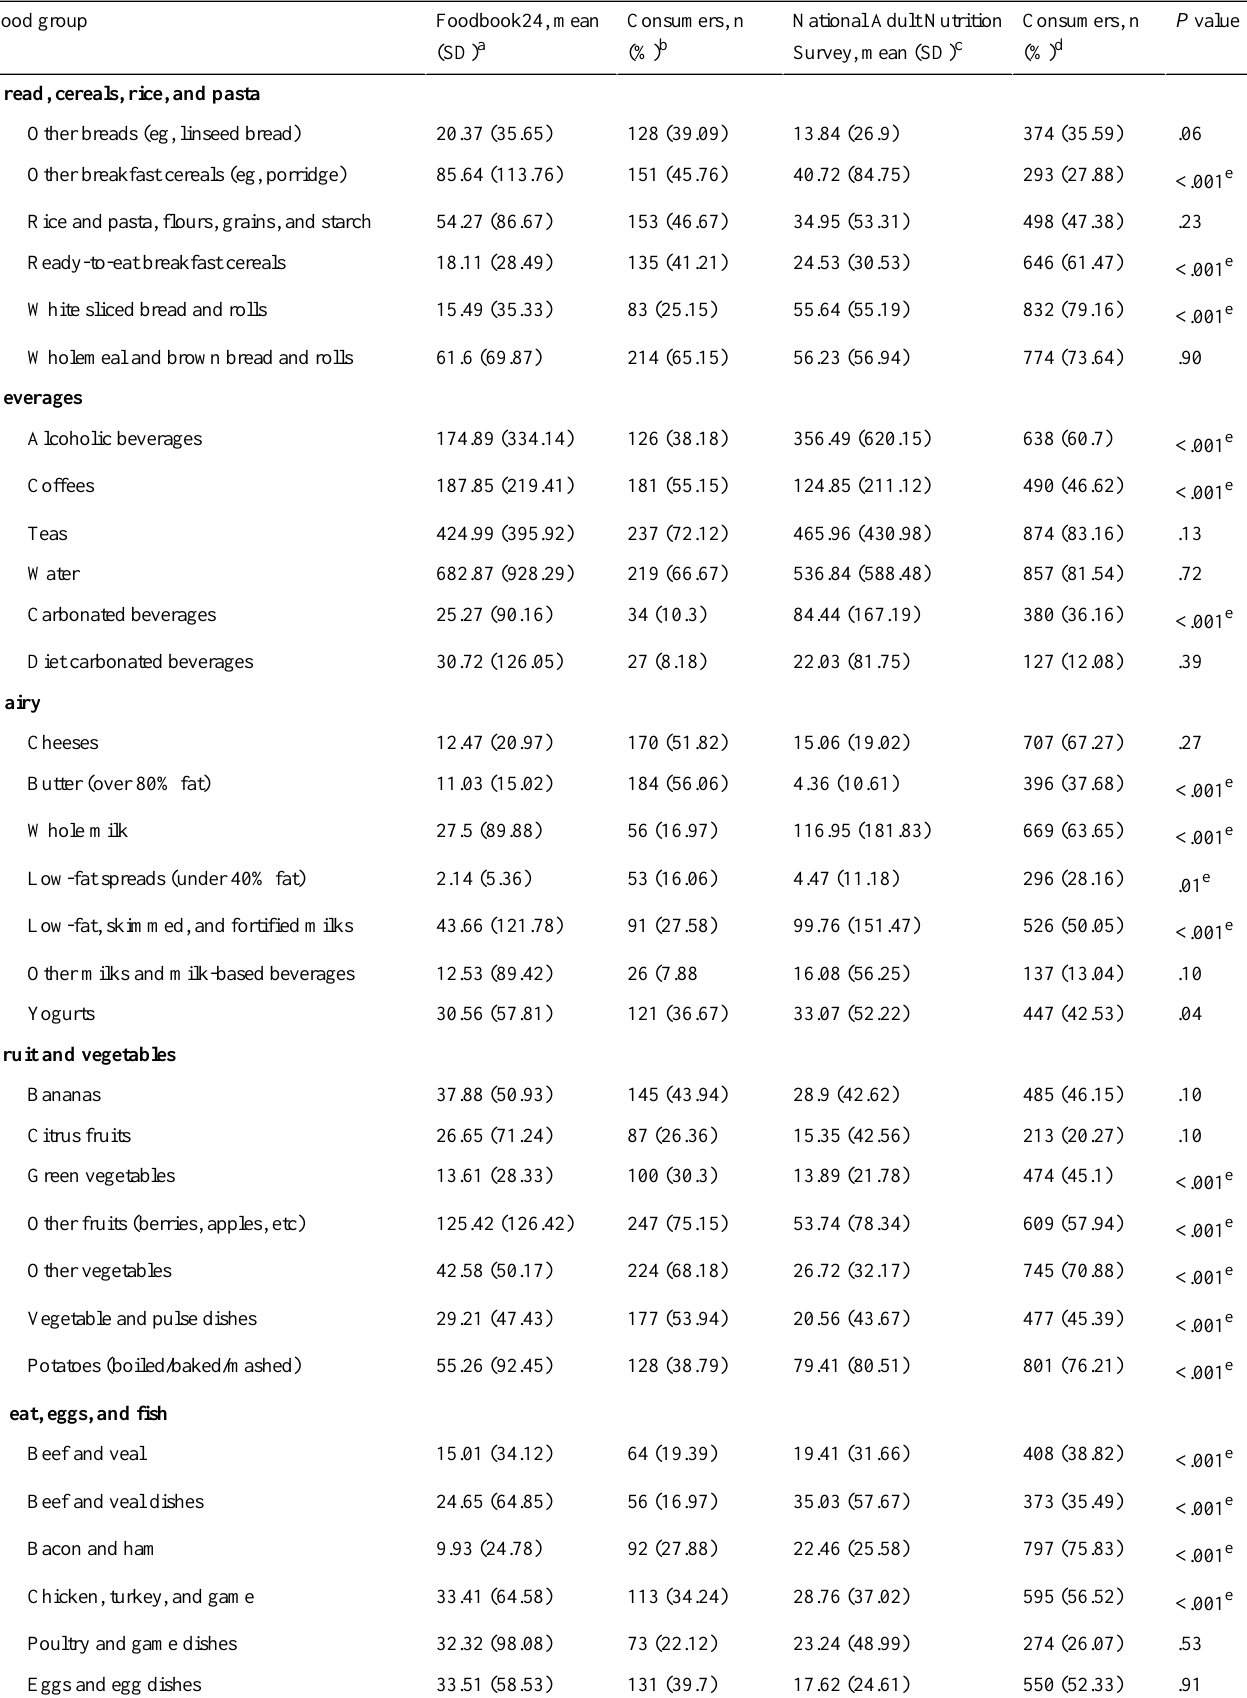
Table 5. Food group intakes (grams) of adequate reporters from the Foodbook24 web-based study (2016) and the National Adult Nutrition Survey